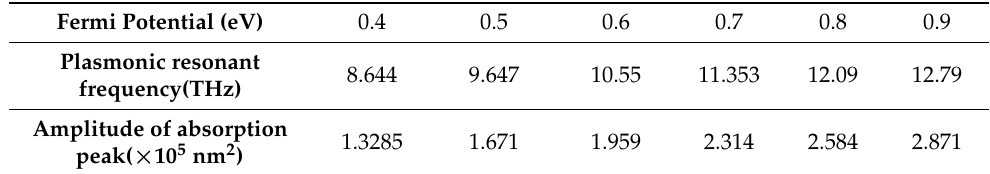
Table 7. The variation of absorption parameters under changisng in combline’ Fermi